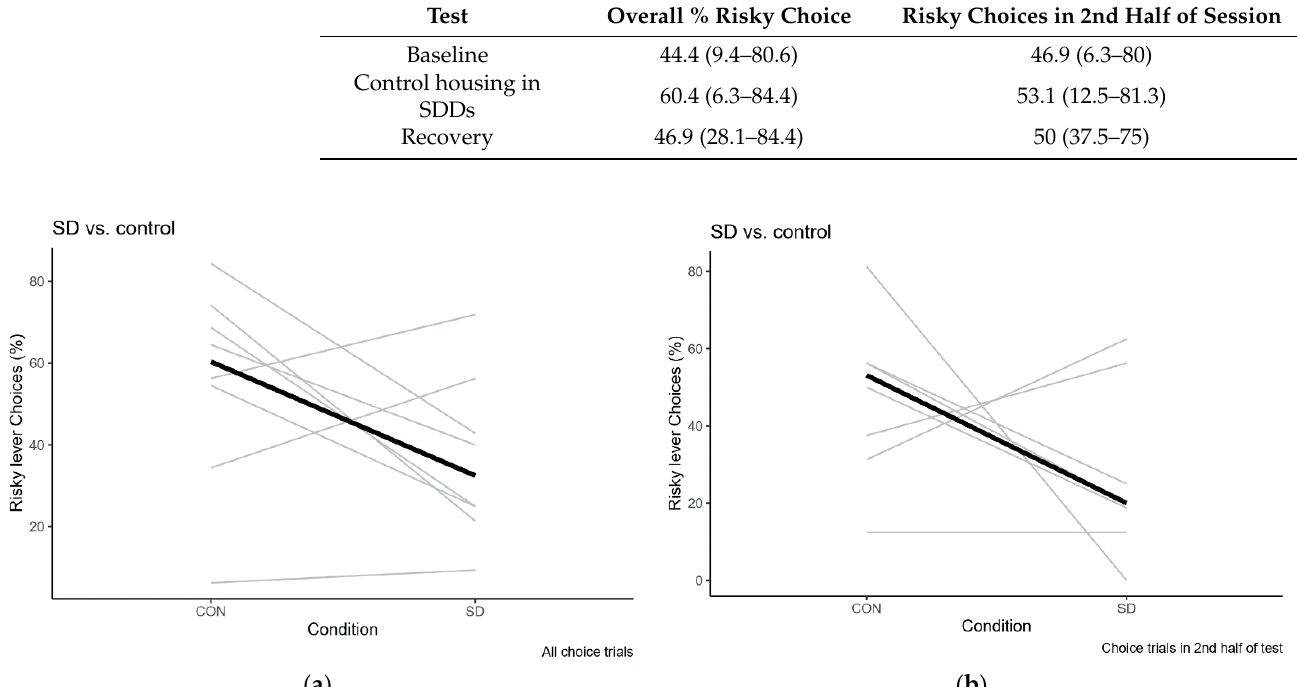
Figure 4. Risk preference after sleep deprivation and the control condition. ( a ) Preference in the completed choice trials from the entire session; ( b ) Preference in the completed choice trials from the second half of the session. Individual data in grey, median values in black. Please note that rat 6 is excluded from Figure 6b because there were no data in the sleep deprivation condition. In this experiment, there is no significant effect of sleep deprivation on risk preference compared to control (as detailed in the text).